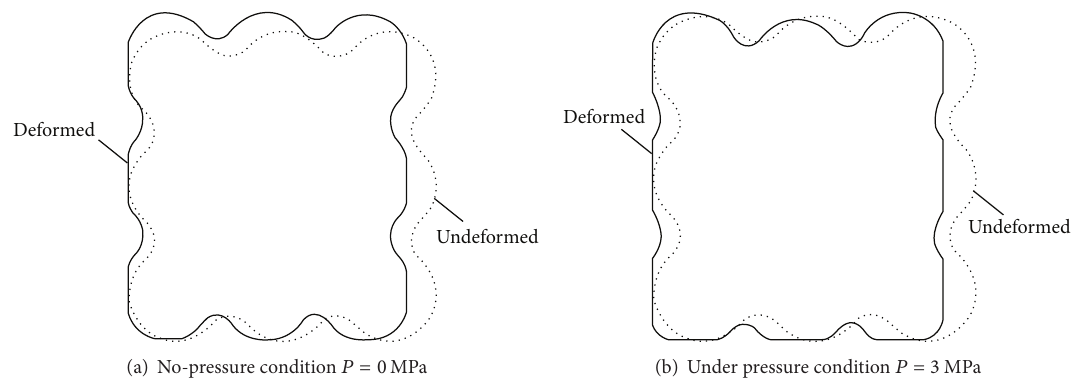
Figure 8: Deformation image of sealing ring.